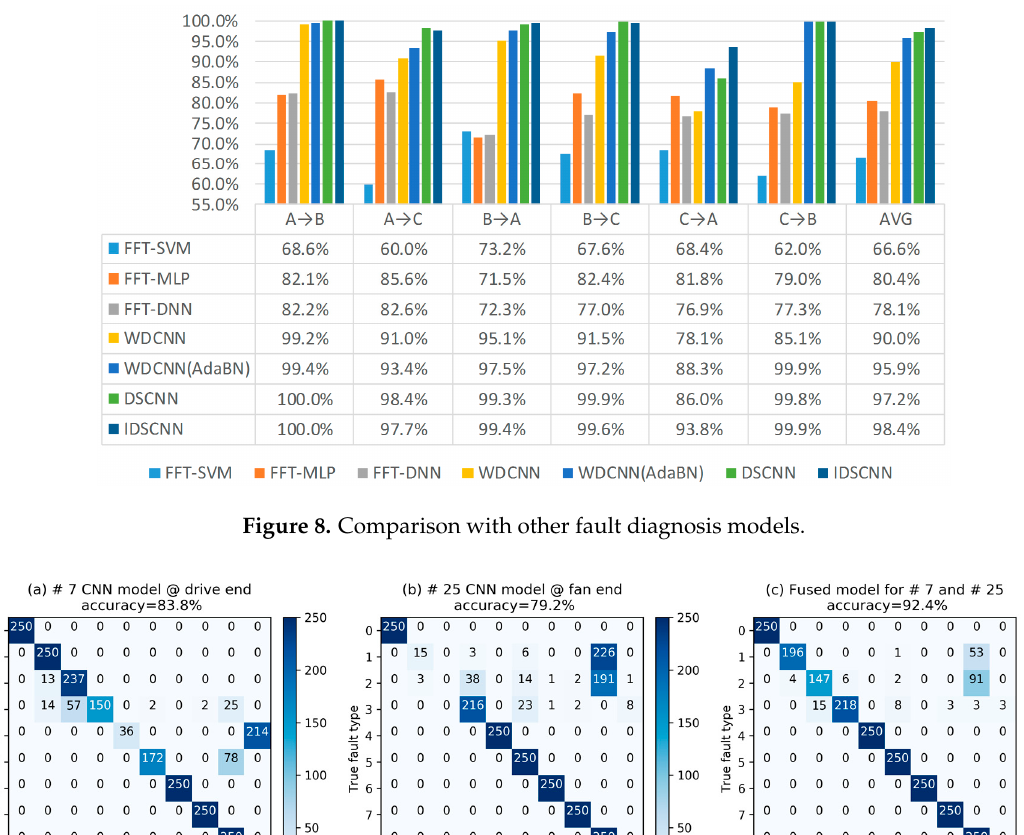
Figure 7. Accuracy of the best IDSCNN models on 20 repeated experiments.